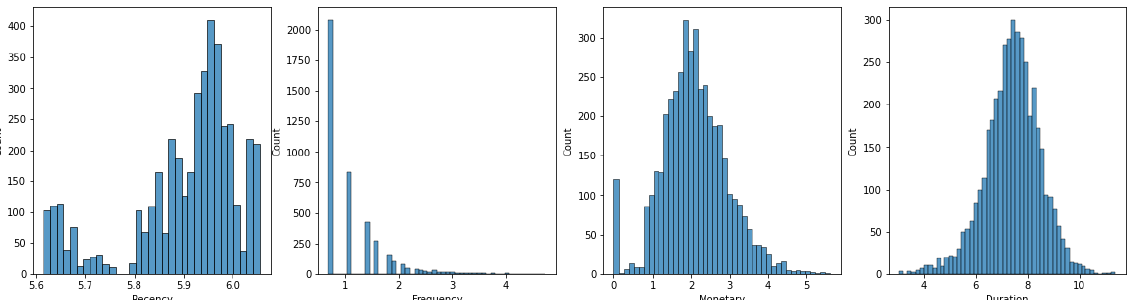
Figure 11. Plot of the scaled distribution of the RFMD values. From left to right: Recency, Frequency, Monetary, Duration.